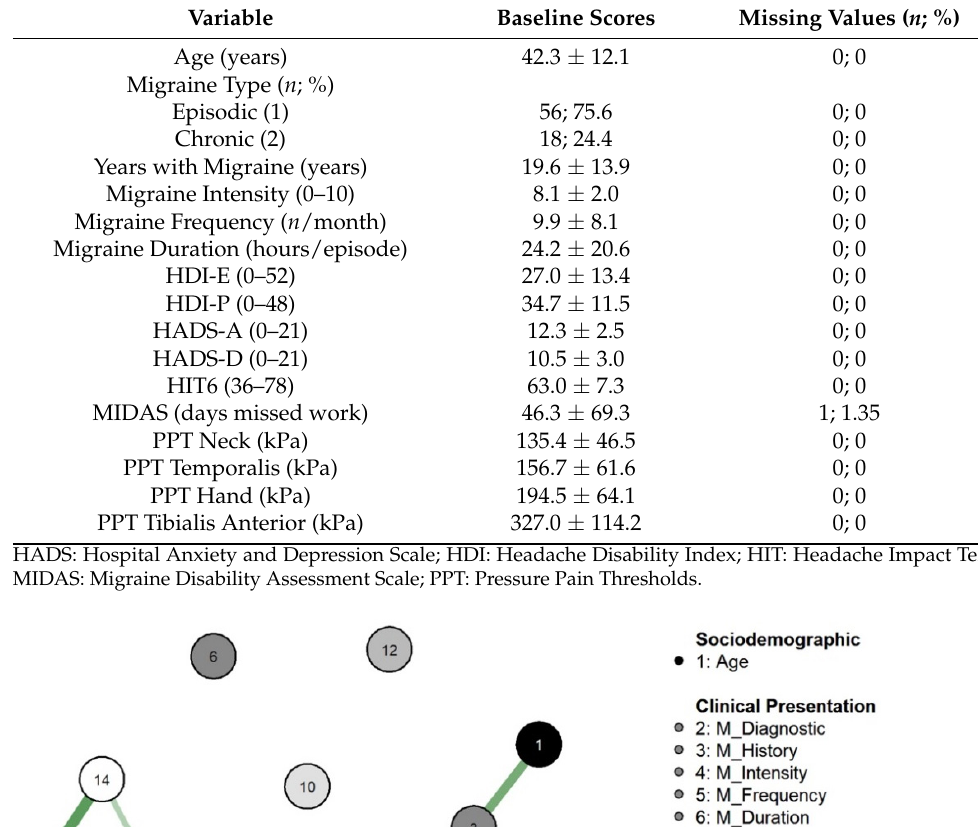
Table 1. Values (mean ± standard deviation= of baseline characteristics of the total sample ( n = 74). Variable